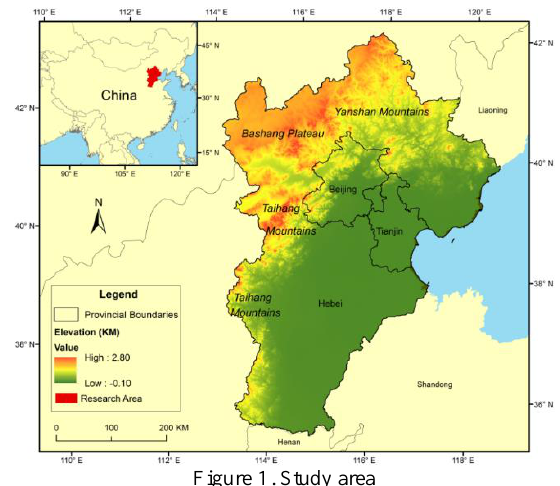
Figure 1. Study area The huge population (110 million, 8% of the China’s population), high-speed urbanization, industrial processes, transportation, and coal consumption for winter heating have resulted in severe air pollution in the BTH region. From Figure 2, it can be found that during the study period, none of the eleven cities reached the Chinese national annual standard (15 μg/m3) and some of their averaged PM2.5 were 500% higher than the national standard and 800% higher than WHO guideline (10 μg/m3).